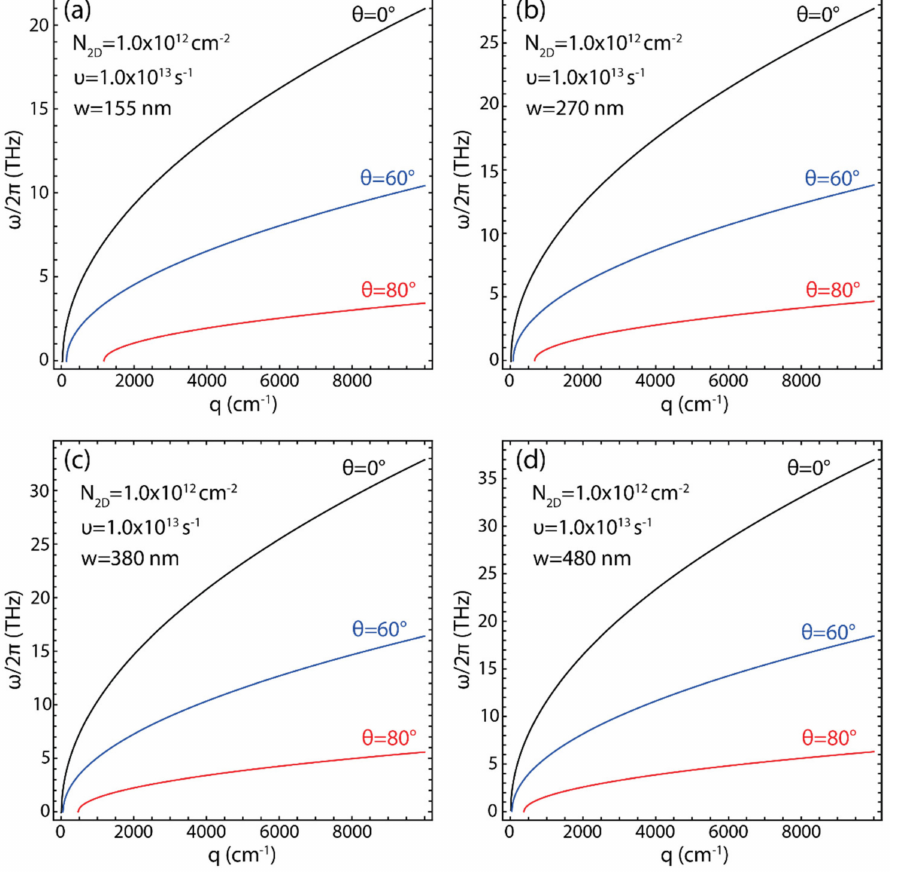
Figure 9. Plasmon frequency–momentum dispersion of 2D GNR arrays of interest, considering different values of charge carrier concentrations ( N 2 D = 1.0 × 10 12 , 2.0 × 10 12 , 4.0 × 10 12 cm − 2 ): ( a ) w = 155 nm, ( b ) w = 270 nm, ( c ) w = 380 nm, and ( d ) w = 480